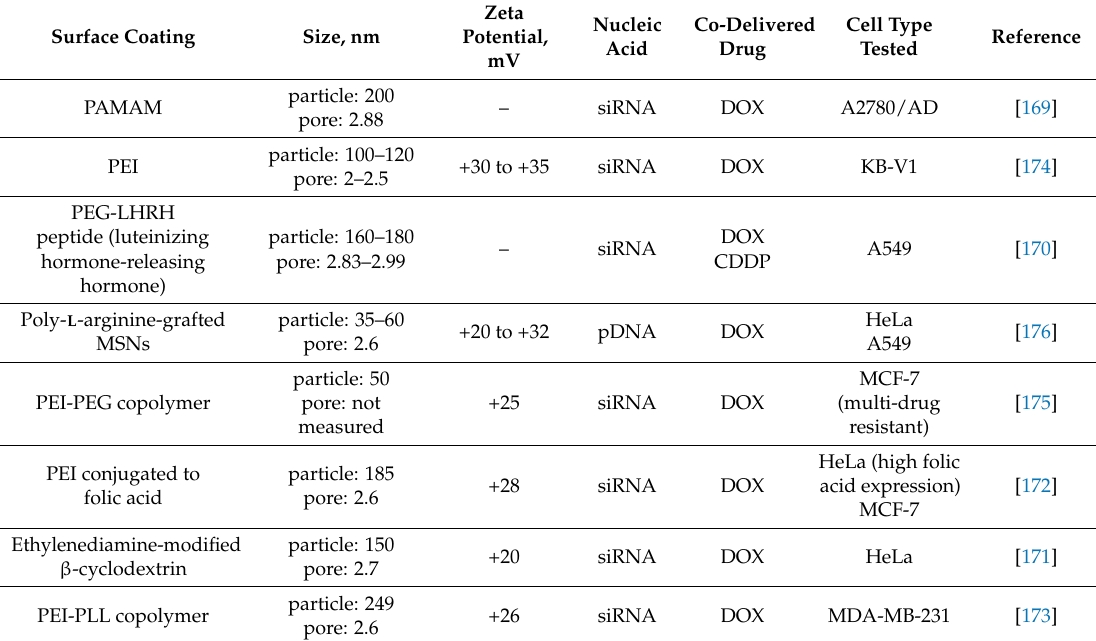
Table 3. Particle and pore sizes and surface coatings in systems for co-delivery of drugs with nucleic acids using